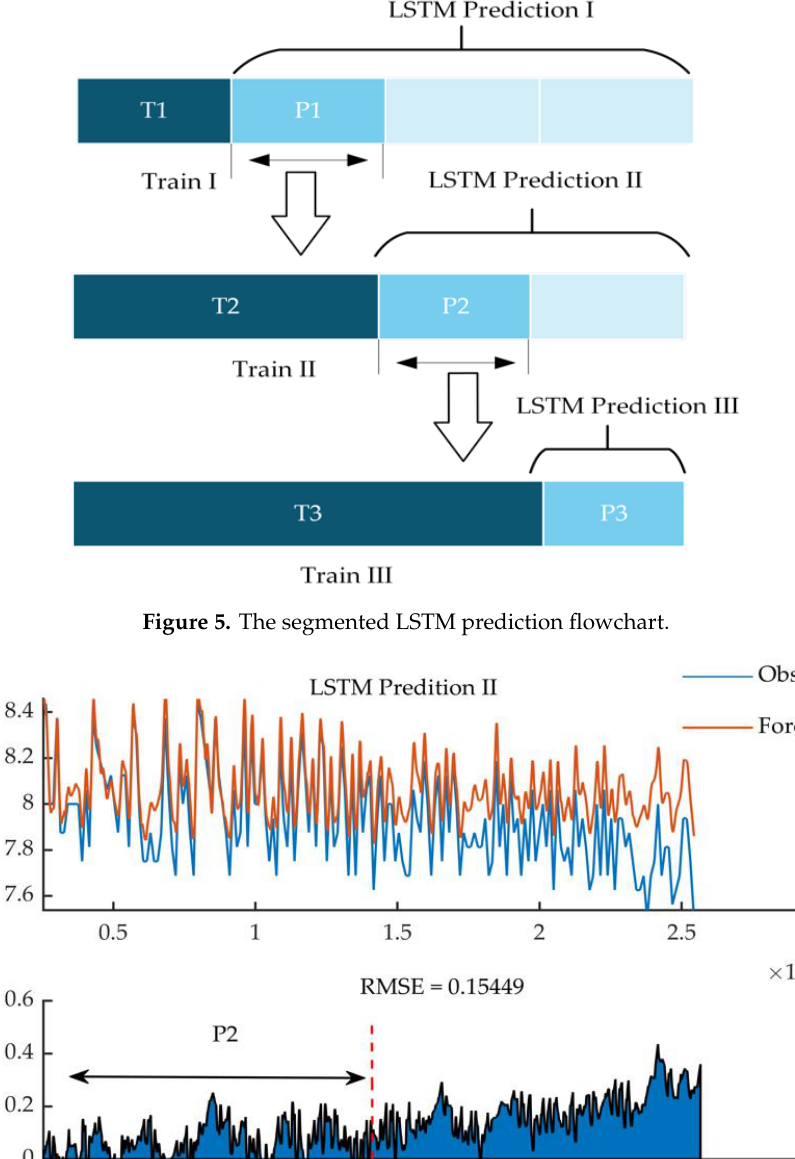
Figure 7. The third LSTM prediction.